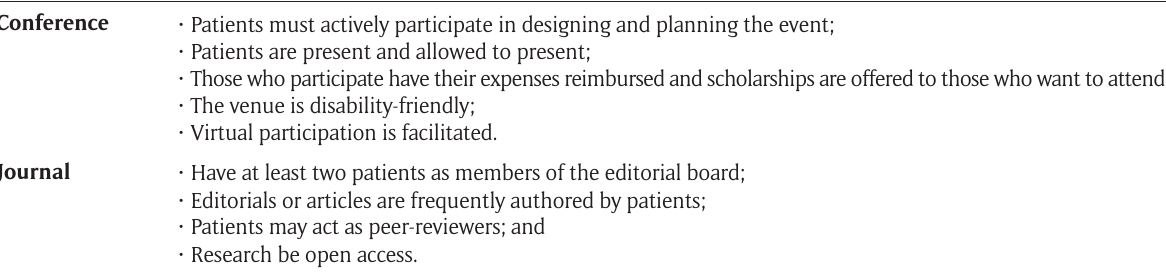
Table 1: Requirements from Patients for Different Scientific Venues. Scientific